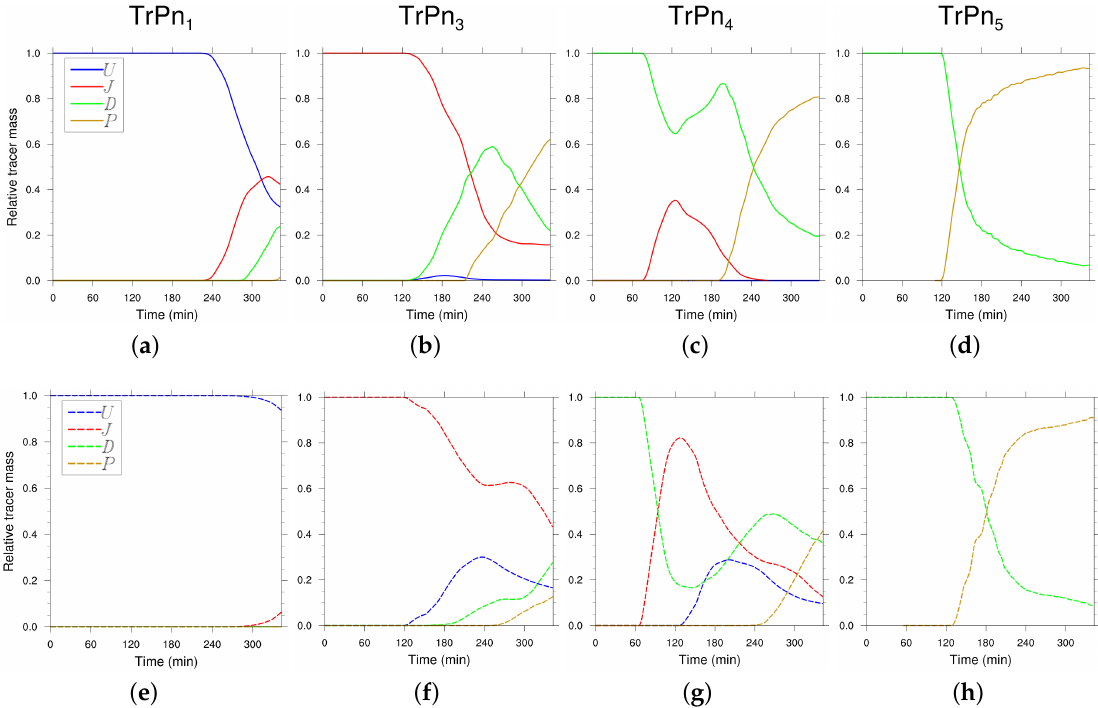
Figure 10. Time series of the relative tracer mass ( R M ) at the different control volumes in the system ( V U , V J , V D and V P ) for tracers TrPn 1 released at U ( a and e ), TrPn 3 released at J ( b and f ), TrPn 4 released at the beginning of D ( c and g ) and TrPn 5 released at the center of D ( d and h ). Note that n = 1 for P1 and n = 2 for P2. Solid lines represent values of P1 (top row), while dashed lines stand for P2 (bottom row). The location of the emission source of each of the tracers is presented in Figure